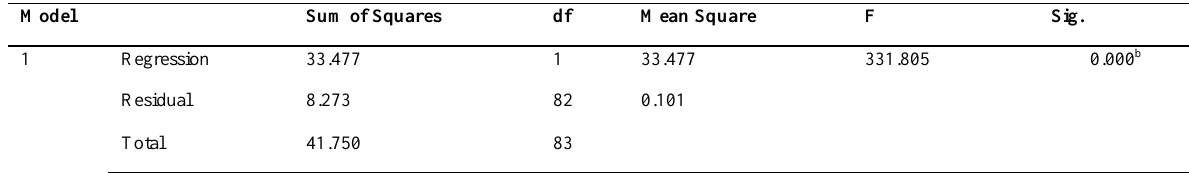
Table 4: An ANOVA of the Regression of Contingent Capital and Performance of Hydroelectric Energy Projects Model Sum of Squares df Mean Square F Sig.